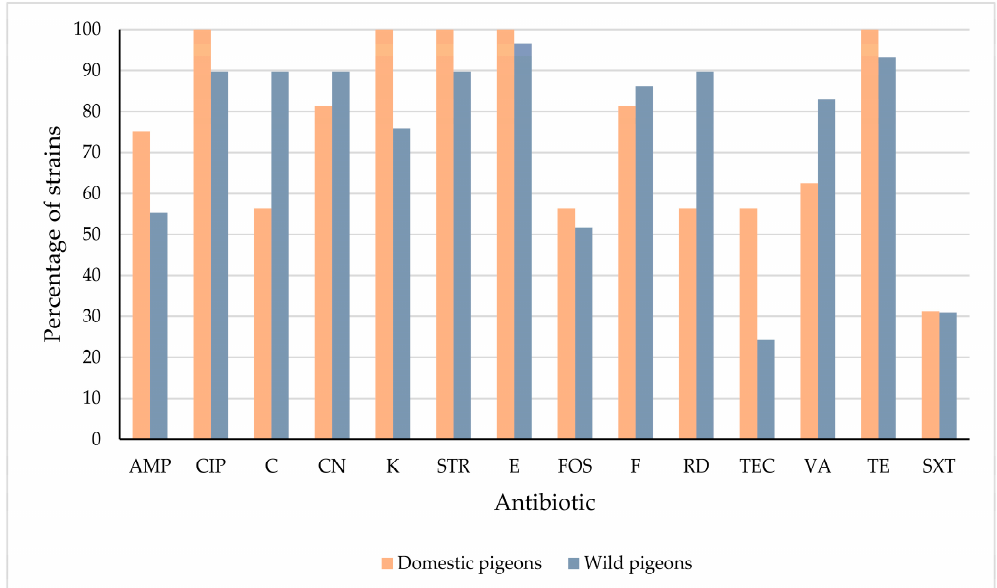
Figure 4. Percentage of Enterococcus faecalis strains from domestic and wild pigeons with resistance or reduced susceptibility to each antibiotic tested. Ampicillin (AMP); ciprofloxacin (CIP); chloramphenicol (C); gentamicin (CN); kanamycin (K); streptomycin (STR); erythromycin (E); fosfomycin (FOS); nitrofurantoin (F); rifampicin (RD); teicoplanin (TEC); vancomycin (VA), tetracycline (TE); trimethoprim-sulfamethoxazole (SXT).